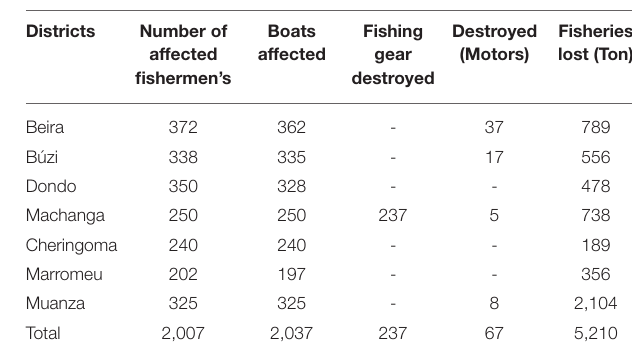
TABLE 3 | Summary of the impacts of cyclones Idai and Kenneth in the province of